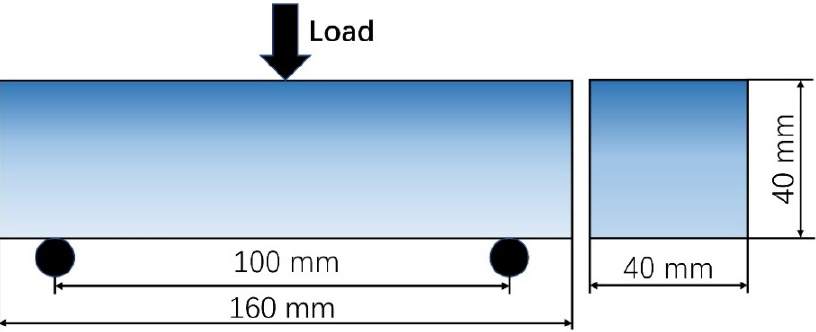
Figure 5. Technical drawings of the three-point bending test.